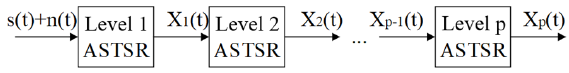
Figure 1. The flow of adaptive STSR method.